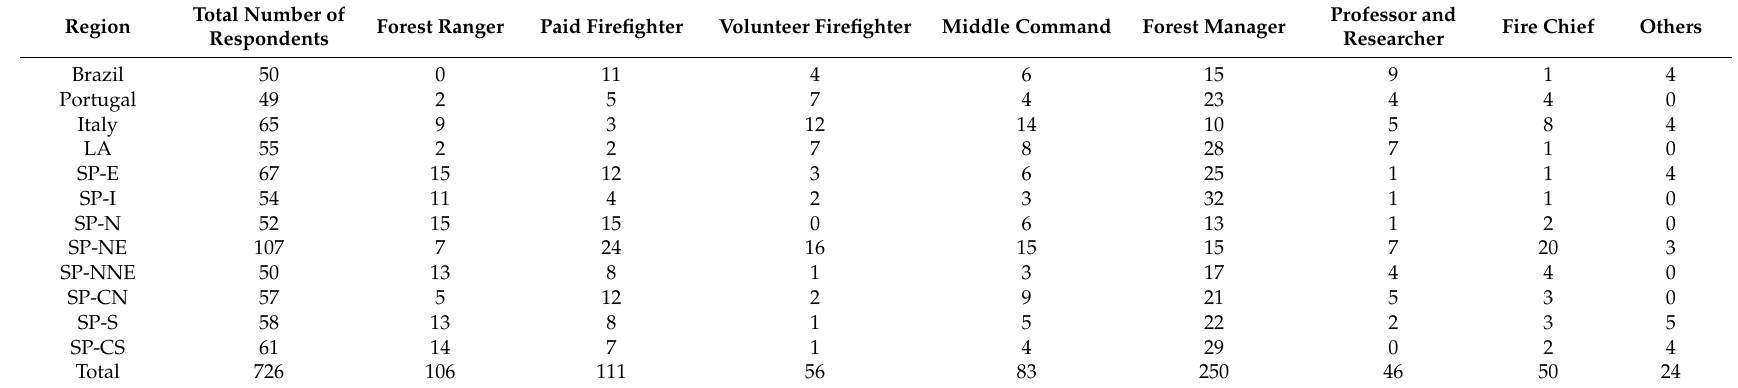
Table 2. Number of respondents by job position and country or